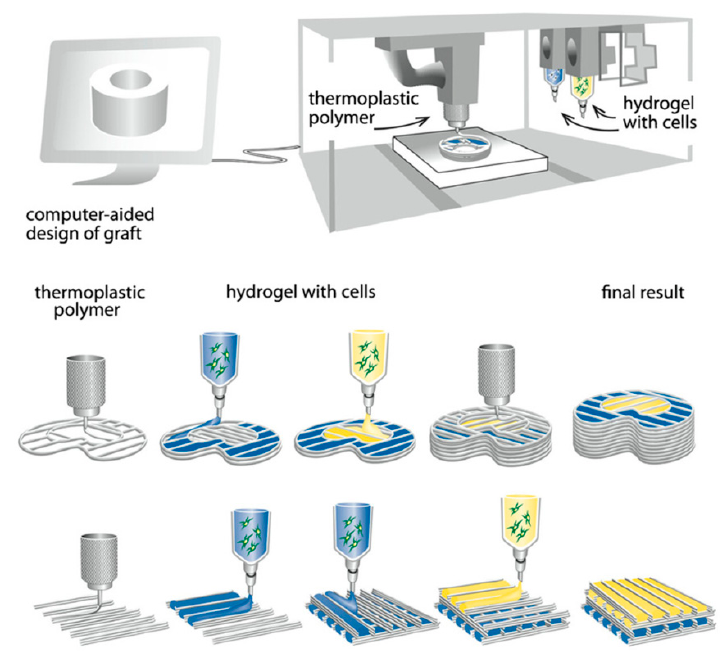
Figure 2. FDM schematic of the bioprinting of tissue and organs.